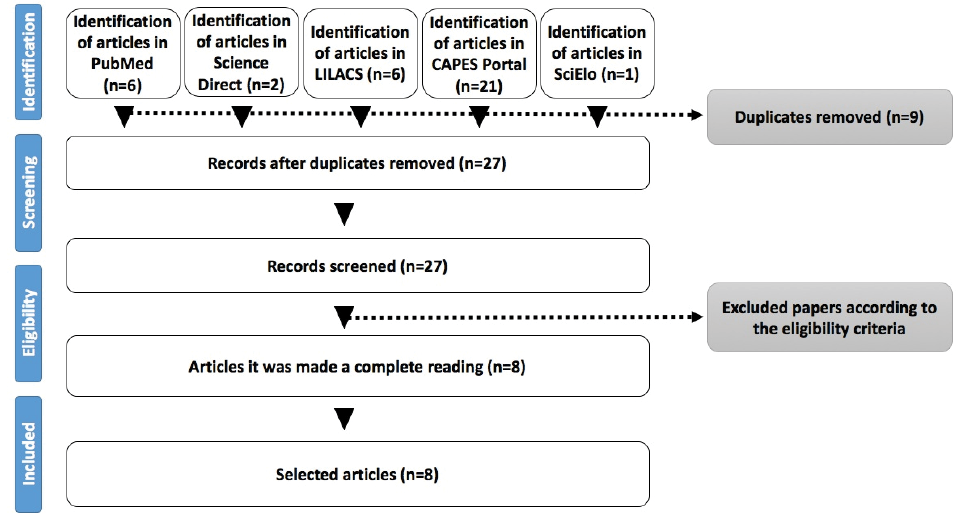
FIGURE 1 - Flow diagram of search procedure and screening process through the different phases of the systematic